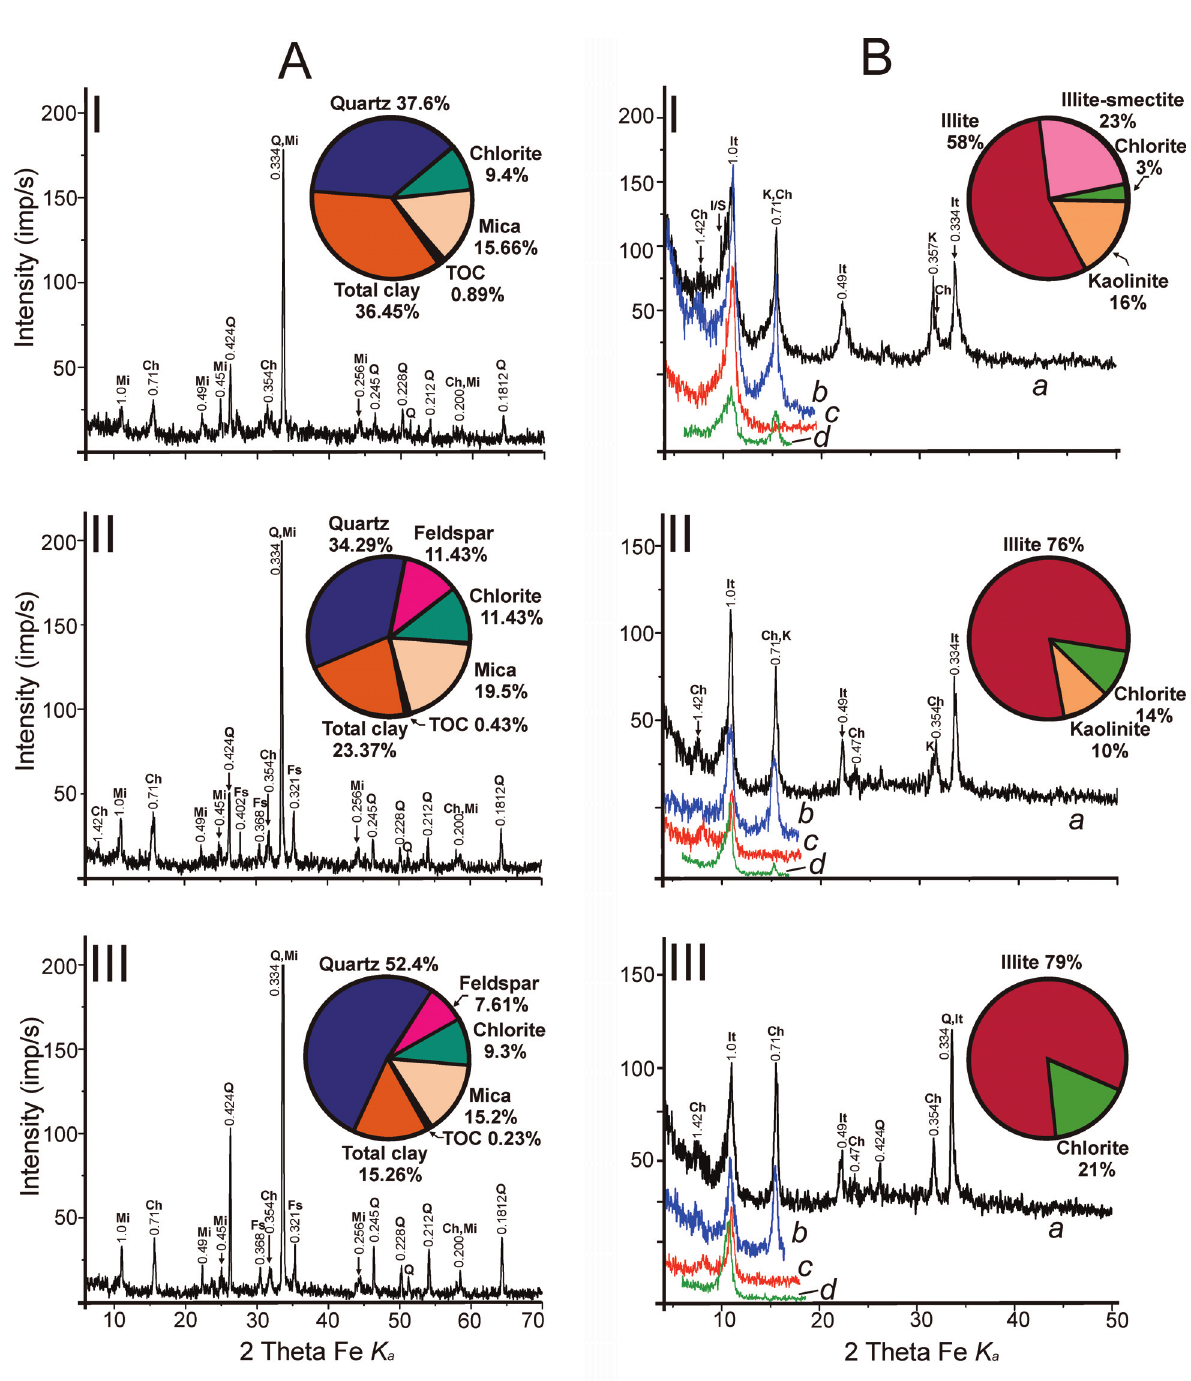
Fig. 7. Diffraction patterns and mineral composition of the Ediacaran Kalus Beds: I , from the Mynkivtsi outcrop; II , from the Sushne-1 borehole; III , from the Peremyshlyany-1 borehole. A , non-oriented whole-rock samples. B , oriented clay fraction samples (fraction finer than 2 µm): а , non-treated (air-dried); b , ethylene glycol solvated; c , heated at 550 ° С ; d , washed with a solution of 15%